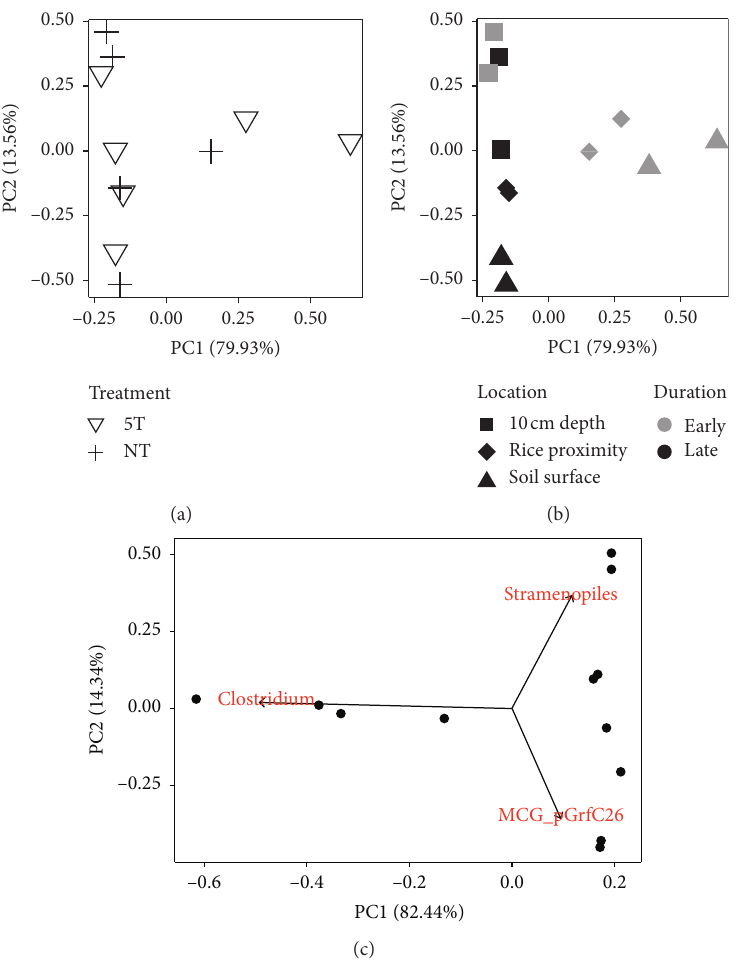
Figure 4: Principal component analysis (PCA) on (a) treatment with no tillage (NT, cross) and 5 times tillage (5T, triangle) and (b) interaction between duration (early vegetative phase (gray) and late vegetative phase (black)) and location (rice proximity, soil surface, and 10cm depth). (c) Arrows show bacteria on genus level. Axes 1 and 2 account for 72 and 16% of the variation,